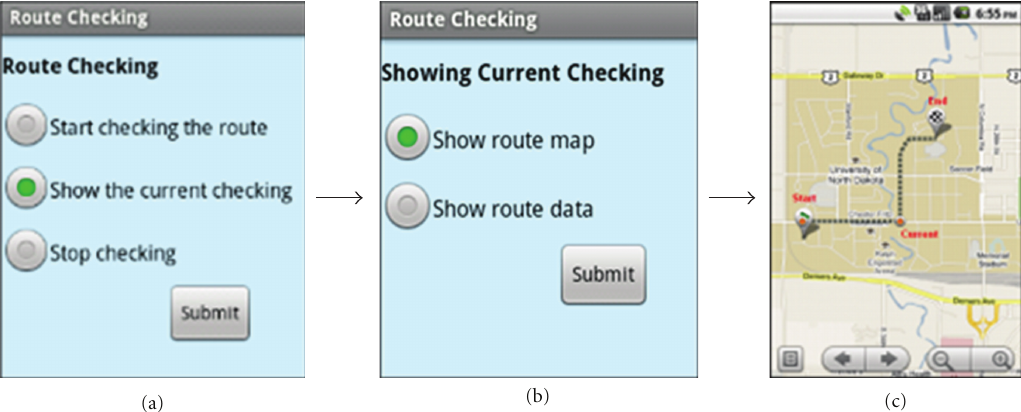
Figure 10: (a) The page of route checking, (b) the page of showing cu rrent checking, and (c) the current position in a stored